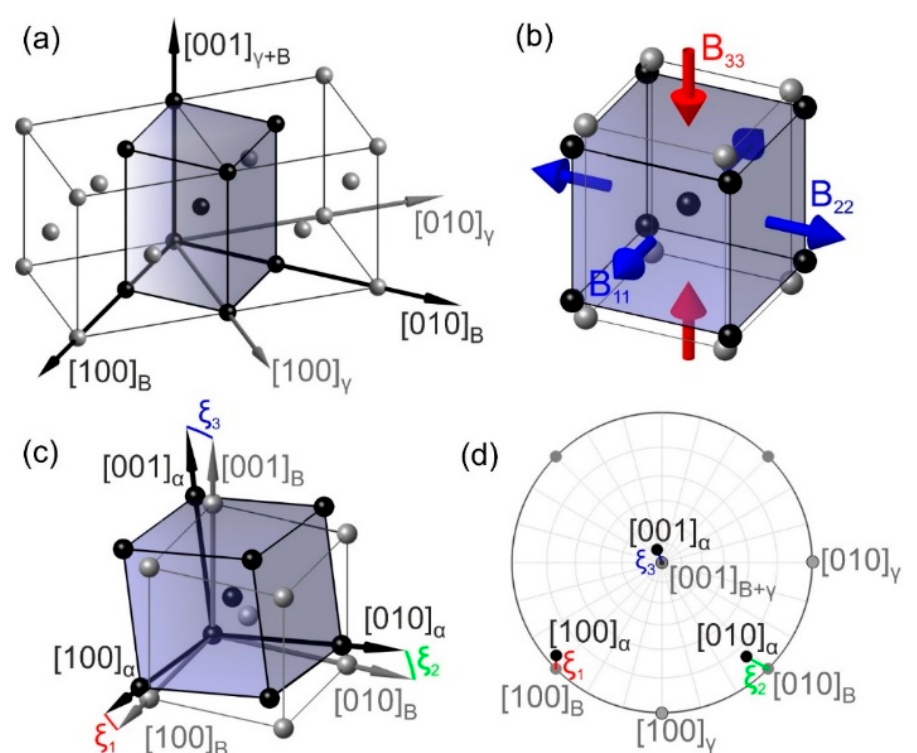
Figure 3. Ideal Bain correspondence and Bain strains and experimentally observed orientations. ( a ) Bain correspondence. ( b ) Bain strains. ( c ) Rigid body rotation. ( d ) Result of all transformation steps and ξ -angles presented in a pole figure.